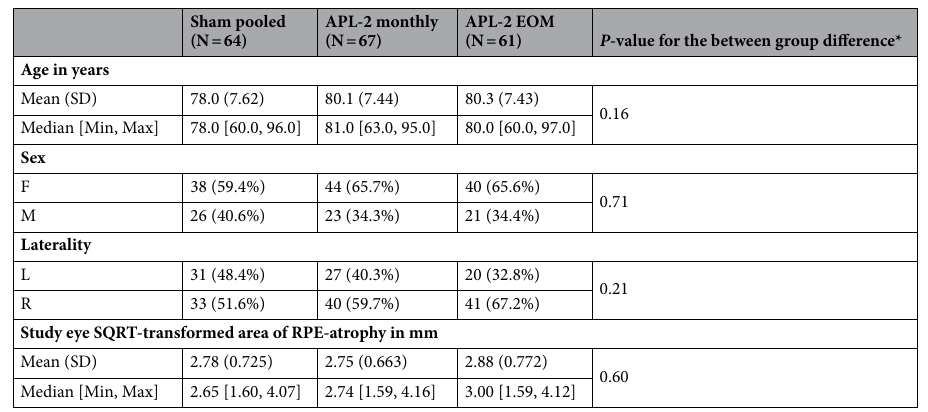
Table 1. Cohort characteristics for the included participants (modified intention-to-treat [mITT] with Spectralis imaging). Retinal pigment epithelium, RPE; SQRT, square-root. *Between-group differences in continuous variables (age and sqrt. area of atrophy) were evaluated with an ANOVA, and Fisher’s exact test was applied for categorical data (sex and